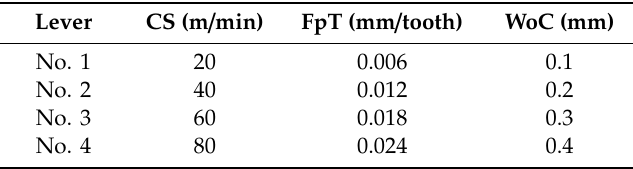
Table 8. Design for milling parameters L 16 (4 5